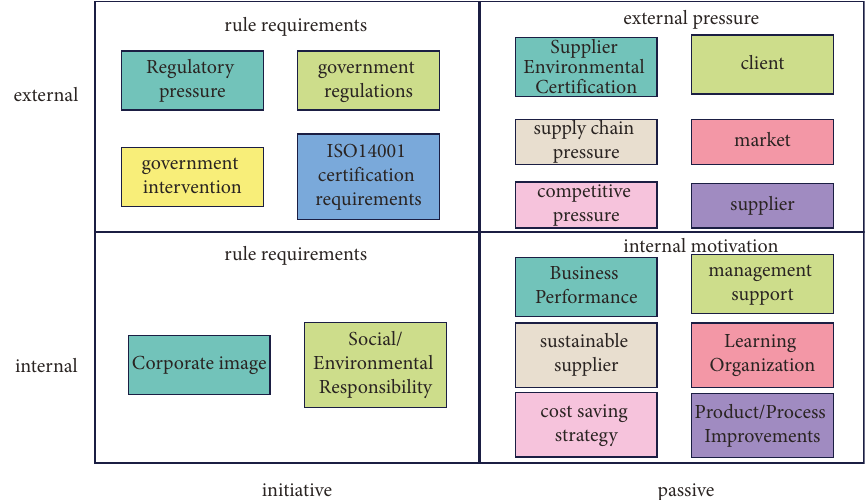
Figure 2: Drivers of supply chain